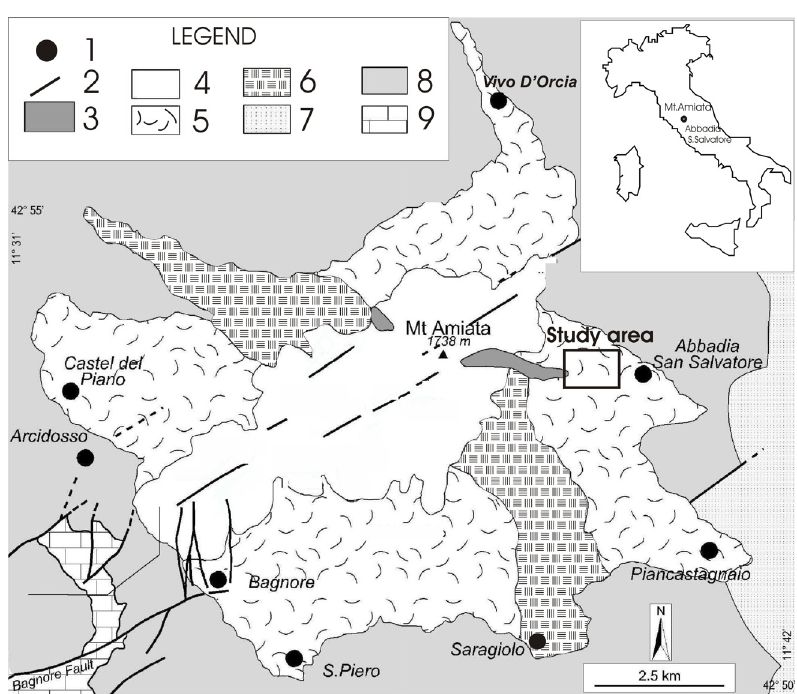
Figure 1. Geological sketch map of Mt. Amiata and location of the study area. Legend: (1) town; (2) fault; (3) third volcanic complex: the Ermeta olivine-latite lava flow: 209±0.29 ka; (4) second volcanic complex: porphyritic rhyodacite dome and lava flow, from 300± 0.04 ka to 190± 0.23 ka; (5) first volcanic complex, upper unit: trachydacite: from 318± 0.08 ka to 217± 0.01 ka; (6) first volcanic complex, lower unit: trachydacite: from 305± 0.005 ka to 241± 0.07 ka; (7) clay and sand: Early Pliocene; (8) Ligurian Units: Jurassic-Middle Eocene; (9) Tuscan Nappe: late Triassic-Oligocene (modified after Brogi et al.